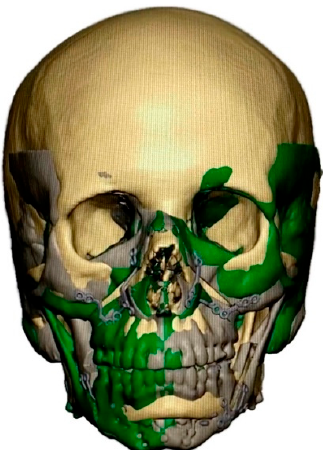
Figure 5. Simultaneous superimposition and mirroring strategy. Superimposed and color-marked are the planned postoperative hard tissue contours (gray), the hard tissue contours mirrored along the median sagittal axis (green), and the standard skull (beige).